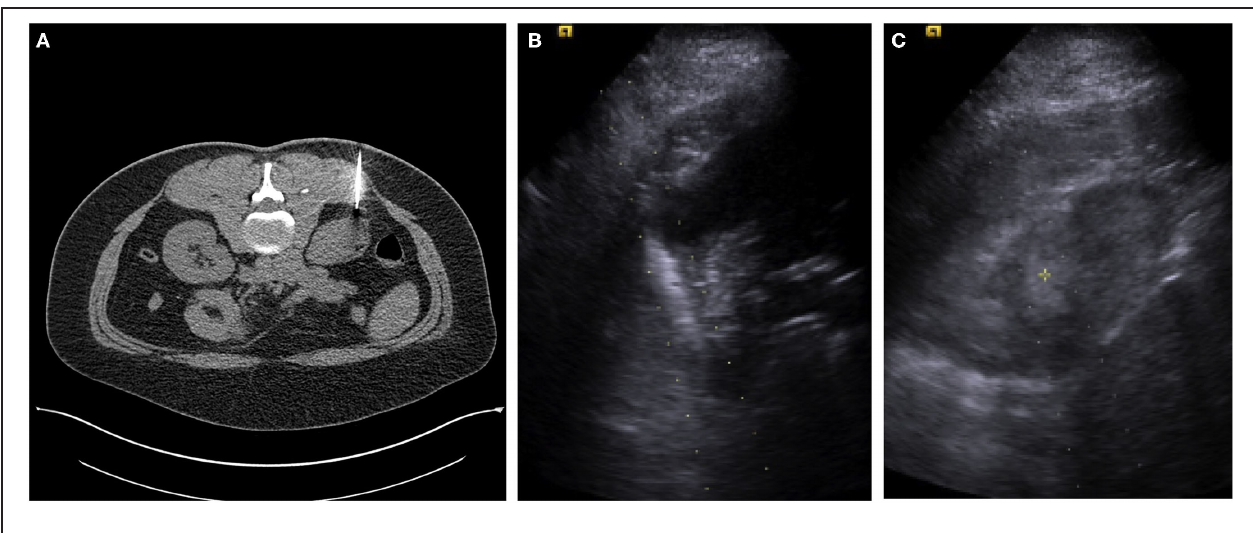
male with an incidentally detected 3.5cm right upper pole renal mass. (C) A second ultrasound image from a percutaneous US guided biopsy using a coaxial technique and an 18-guage needle for core biopsy. Pathology reported as renal cell carcinoma, conventional clear cell type, Furman grade